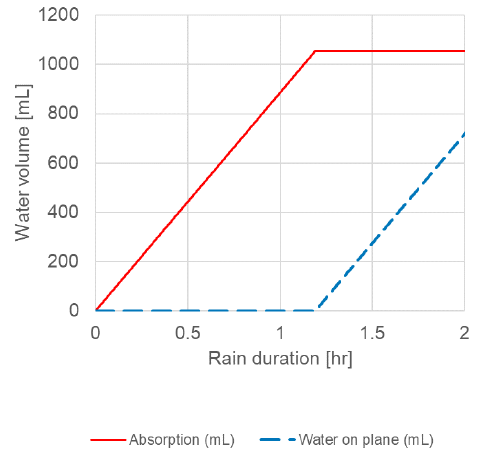
Figure 3. Accumulated water volume on the material and accumulated absorption during a defined standard rain event when implementing the Hall and Hoff [25] model.